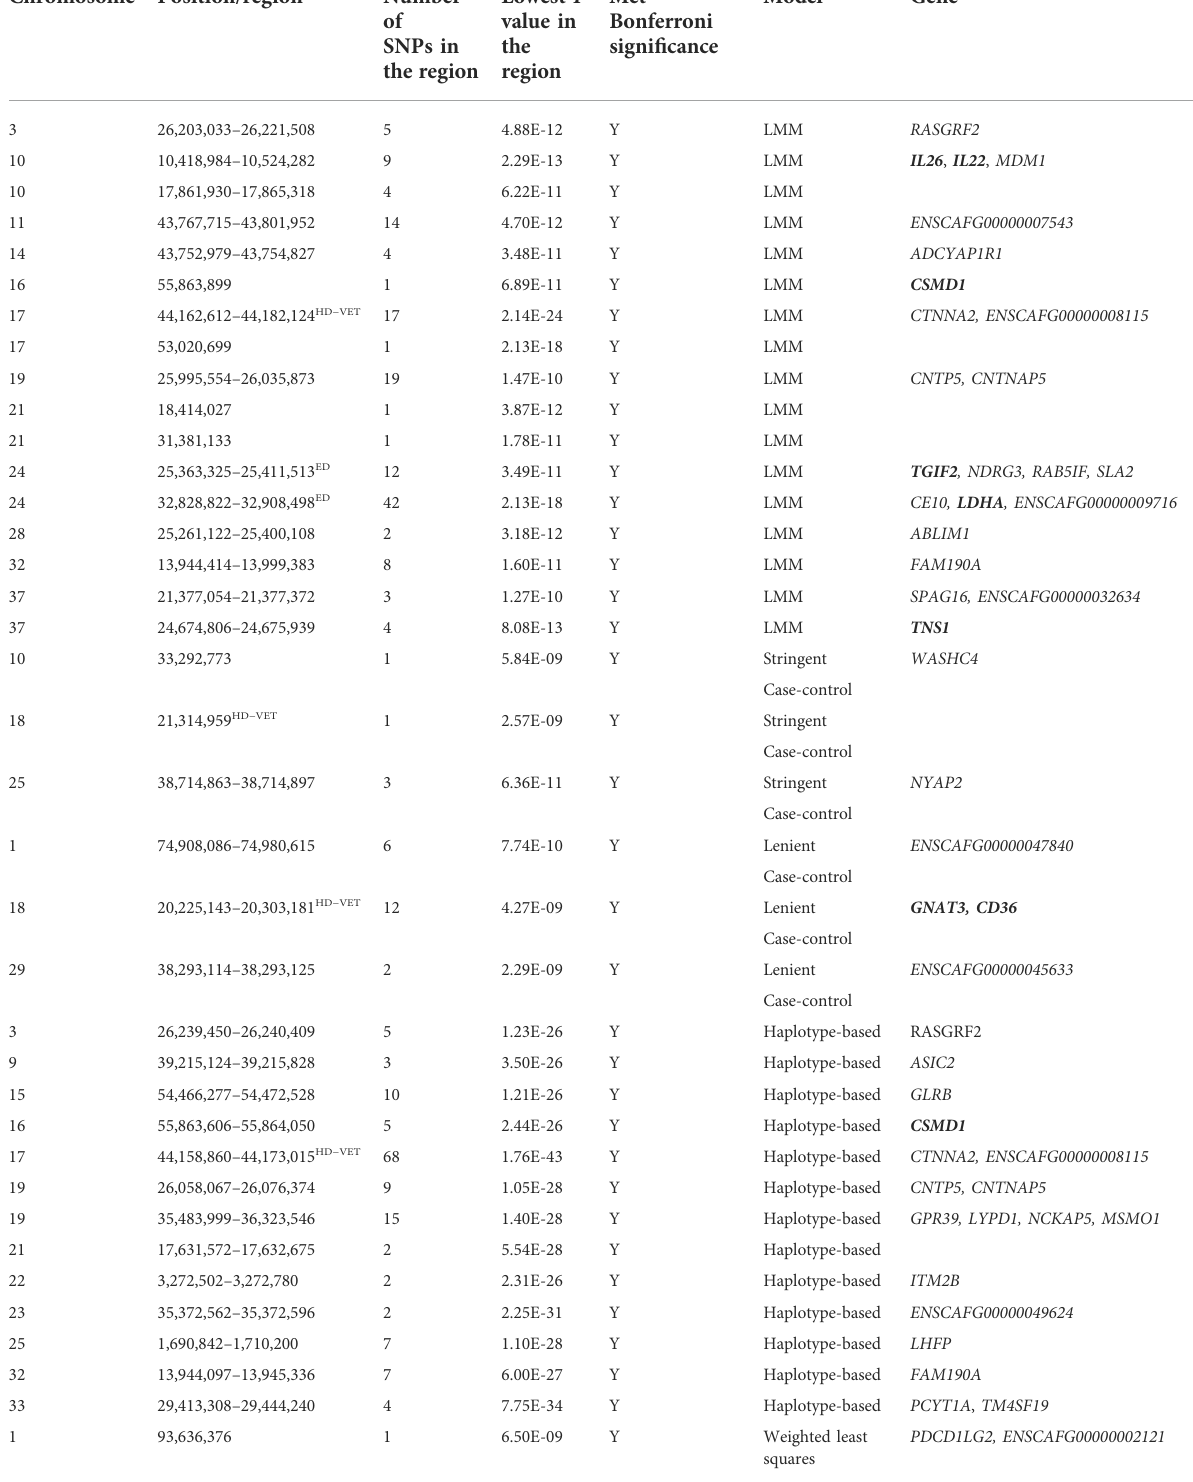
TABLE 6 Top candidate loci associated with anterior cruciate ligament rupture in across-breed GWAS using breed phenotypes and four different association models. Chromosome Position/region Number